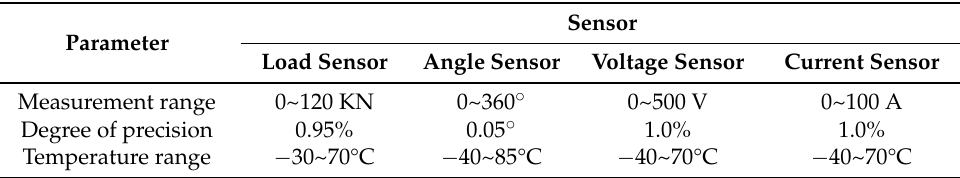
Table 1. Specifications of the four types of sensors.